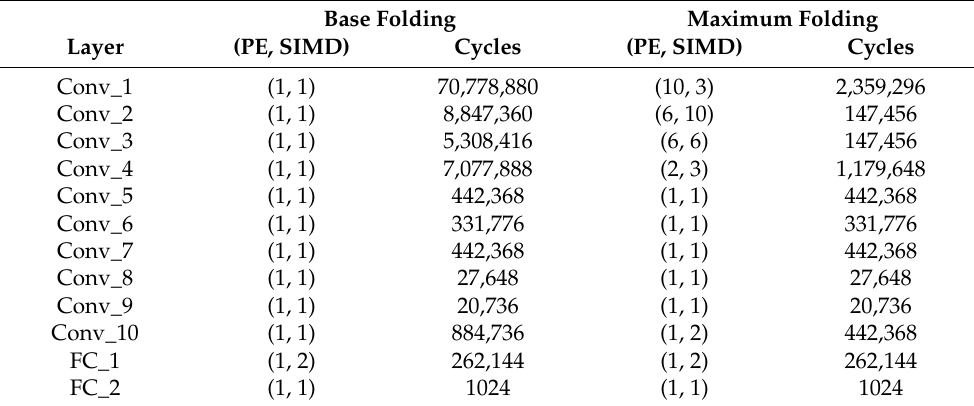
Table 3. Parallelization settings and their respective estimated number of clock cycles.